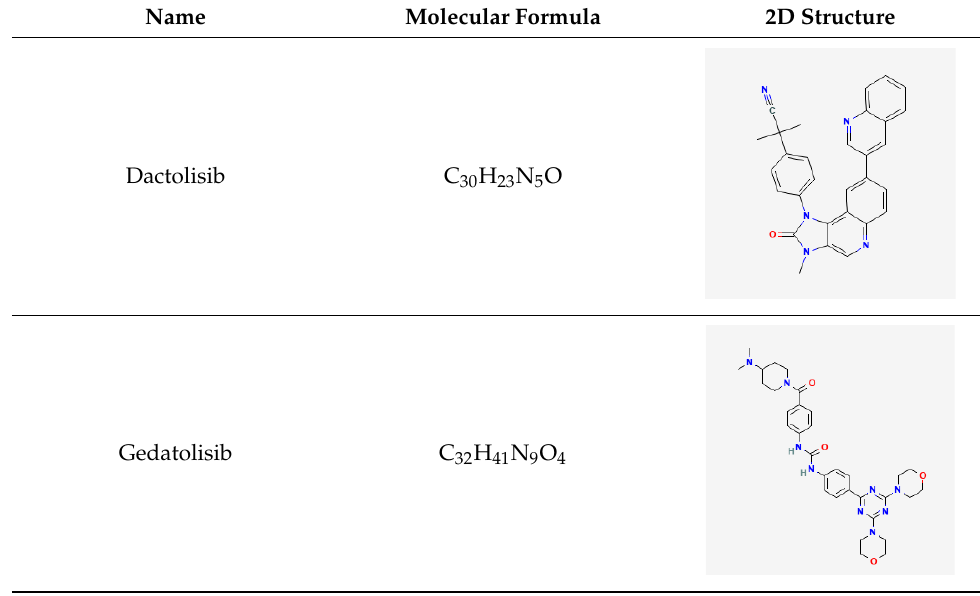
Table 2. Chemical structure of dual pathway inhibitors.